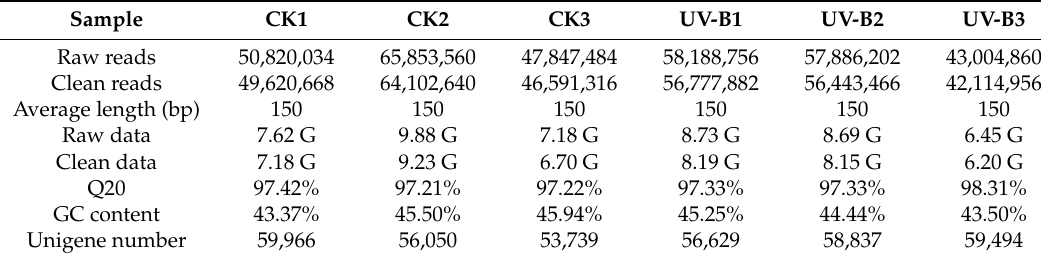
Table 1. Statistics of different samples reads data